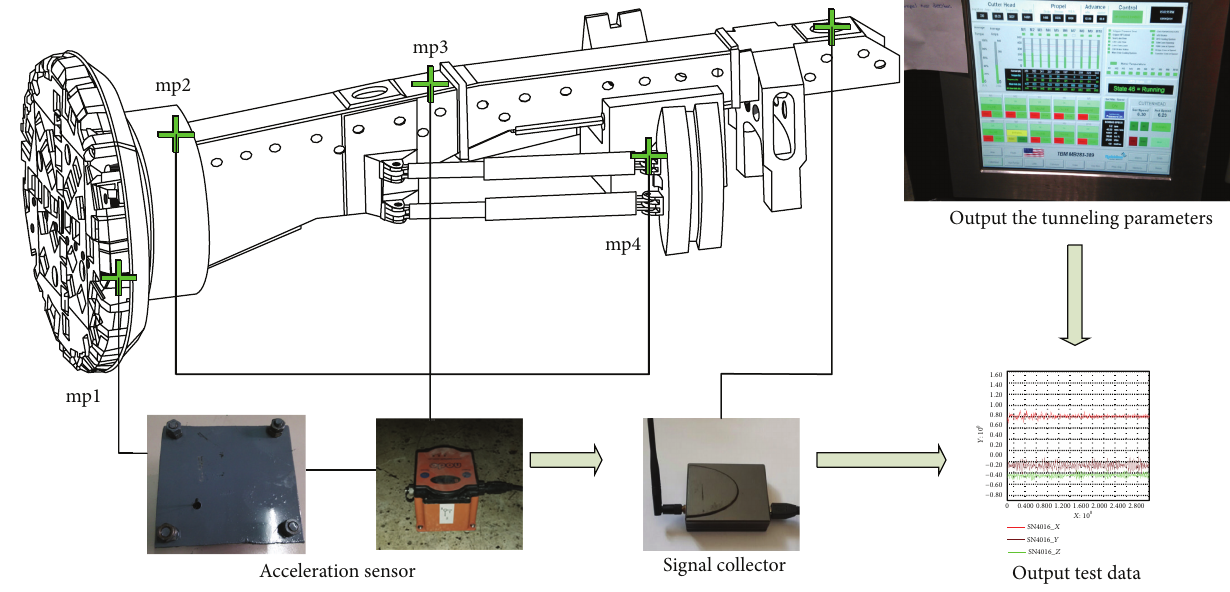
Figure 7: The composition diagram of the wireless test system.